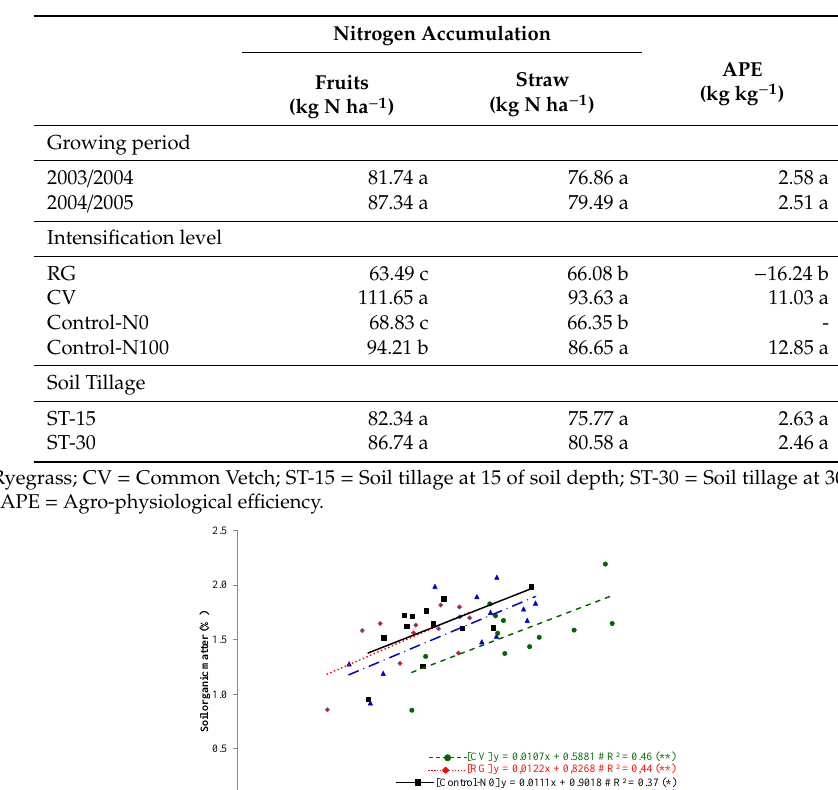
Table 5. The main e ff ect of growing periods, intensification level, and soil tillage on N accumulation in pepper fruits and straw, and agro-physiological e ffi ciency of pepper crop. Values belonging to the same variable followed by the same letter are not statistically di ff erent, according to LSD (0.05).